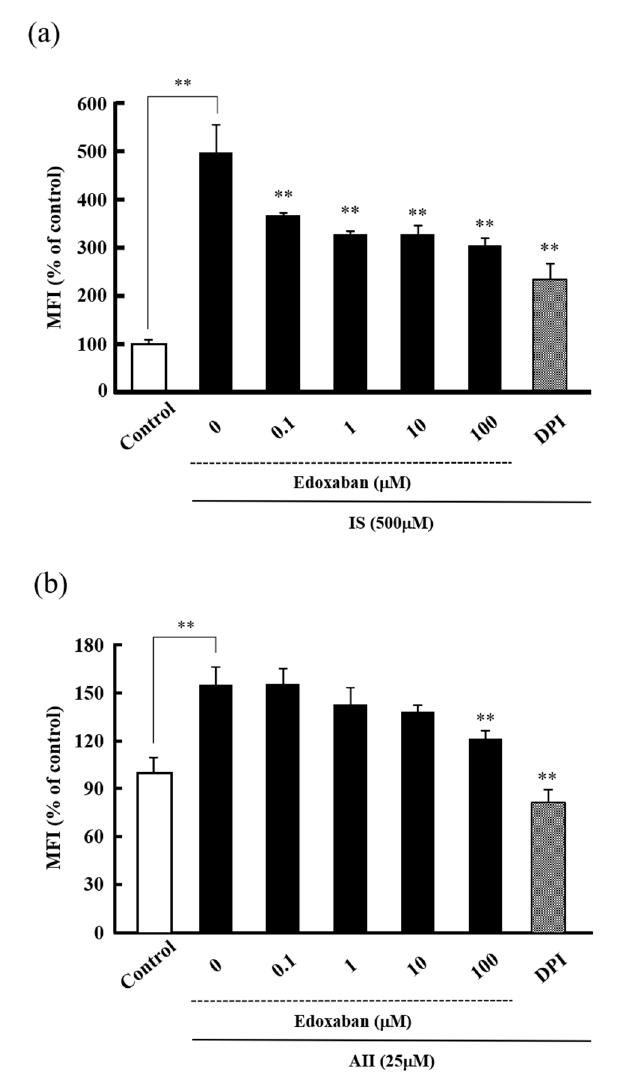
Figure 2. E ff ect of edoxaban on indoxyl sulfate (IS) or angiotensin II (AII)-derived ROS production in HK-2 cells. E ff ect of edoxaban (0.1–100 µ M) and DPI (50 µ M) as an inhibitor of NADPH oxidase on IS ( a ) or AII ( b ) derived intracellular ROS production in HK-2 cells. Values are expressed as the mean ± S.D. ( n = 4). ** p < 0.01 vs. IS or AII